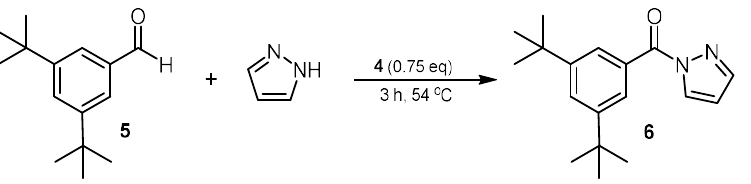
Figure 3. Preparation of (3,5-di- tert -butylphenyl)(1 H -pyrazol-1-yl)methanone ( 6 ) from 3,5-di- tert - butylbenzaldehyde ( 5 ) using a substoichiometric quantity of oxoammonium salt 4 .